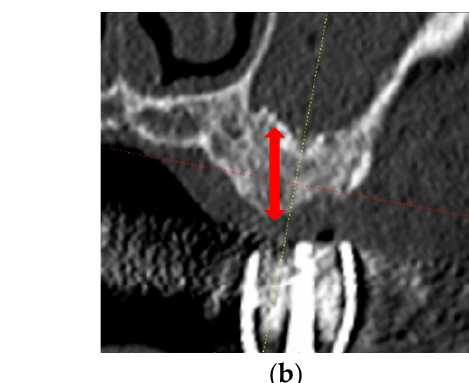
shows pre-vertical bone height; ( b ) Pre-implantation (frontal view), the red allow shows post-vertical